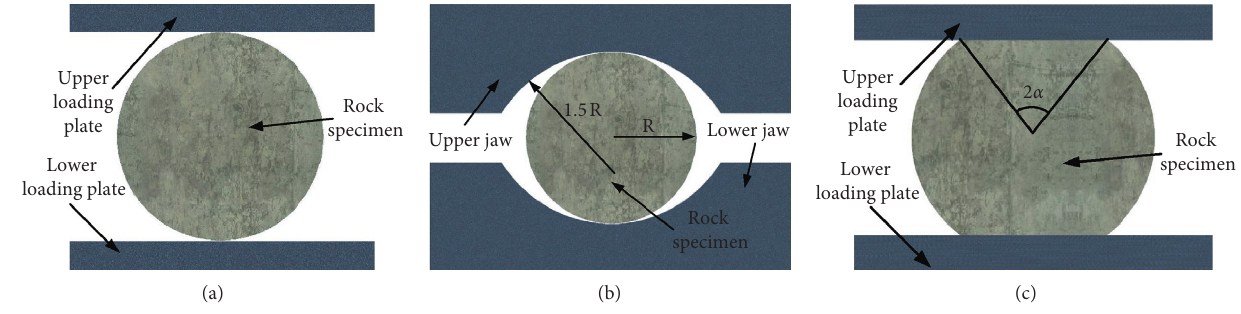
Figure 1: Typical Brazilian tests: (a) flat loading, (b) curved loading, and (c) Flattened